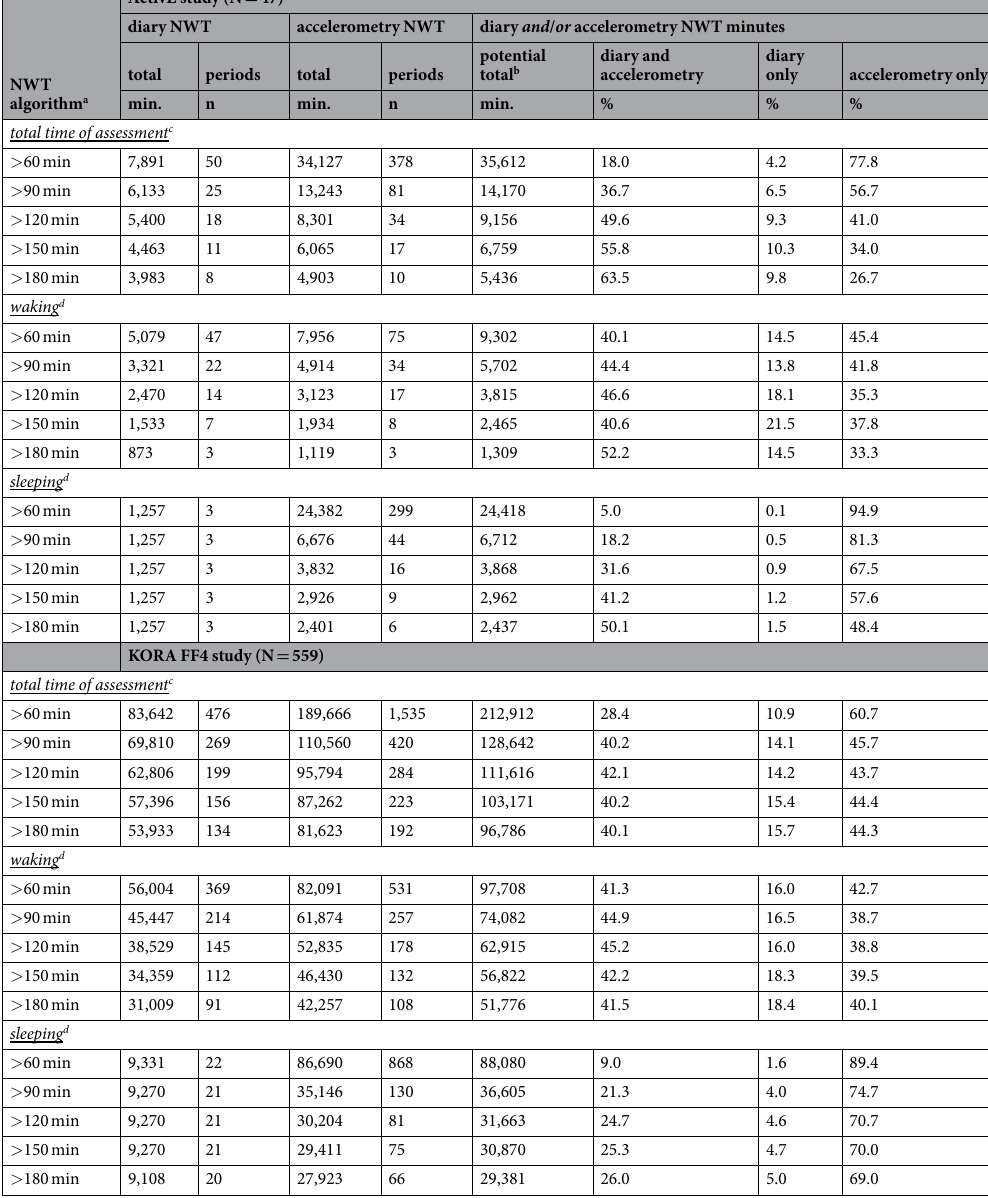
Table 3. Overlap of accelerometry and diary NWT periods identified using the > 60-min to > 180-min algorithms. NWT, non-wear time. a Algorithms were applied to diary and accelerometry data to check for self- reported NWT periods > 60, > 90, > 120, > 150, and > 180 minutes or NWT periods based on consecutive acceleration zero-counts > 60, > 90, > 120, > 150, and > 180 minutes, respectively. b Potential total NWT includes NWT which is NWT detected by either diary , accelerometry , or both . c Analyses were conducted from the first to the last recorded time point of assessment in the diary. d Waking and sleeping phases were derived from participants’ diary